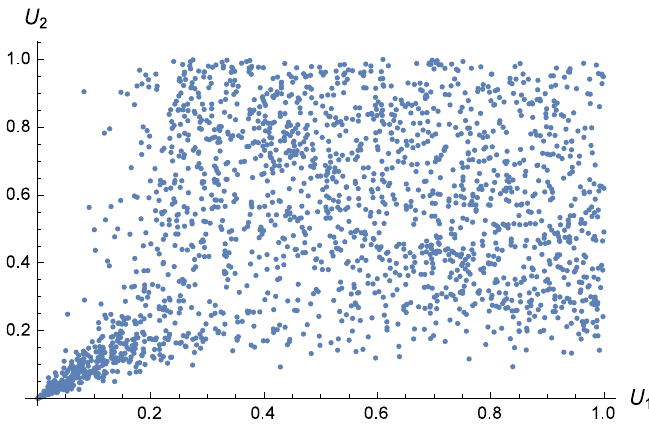
Figure 2. Scatterplot of the SAHARA copula for θ = 4.5464 and (cid:101) = 2; τ = 0.25.